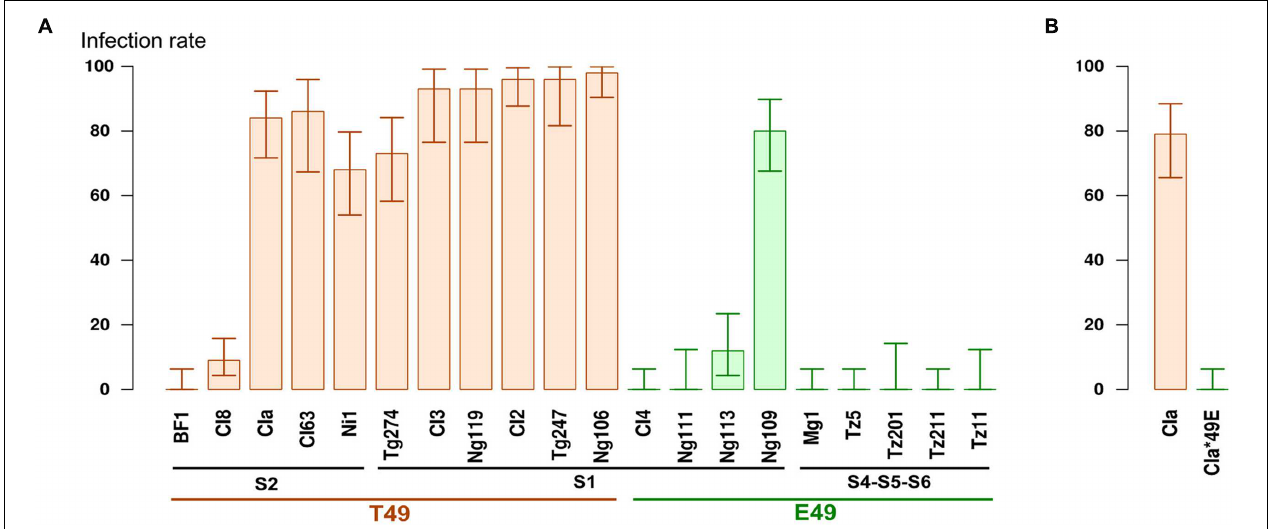
FIGURE 1 | (A) Percentage of infected plants on the Tog7291 accession 4 weeks after inoculation. Plants were inoculated with RYMV isolates representing different strains of the virus (S1, S2, S4, S5, S6) and distinguished by a T or E amino acid at position 49 of the VPg. The error bars represent 95% confidence intervals. (B) Percentage of infected plants on Tog7291 inoculated with the wild-type CIa isolate and the mutant CIa ∗ 49E 4 weeks after inoculation.